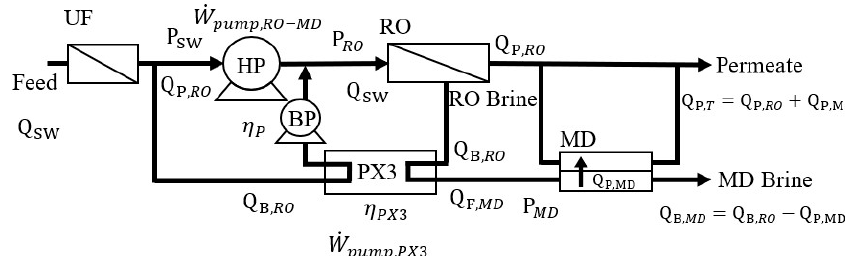
Figure 4. Schematic of the hybrid RO-MD process.